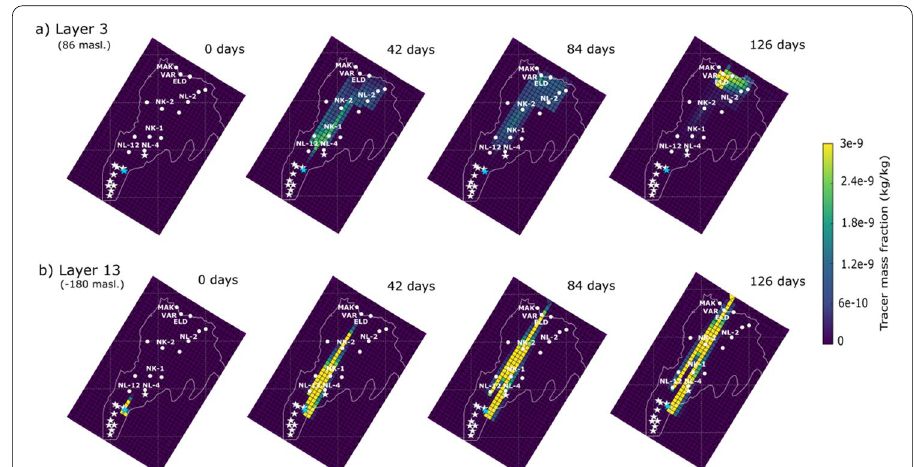
Fig. 16 Model results for tracer test performed in 2018–2019. The results are shown at a different time intervals of 0 day, 42 days, 84 days and 126 days for layer 3 ( a ) and layer 13 ( b